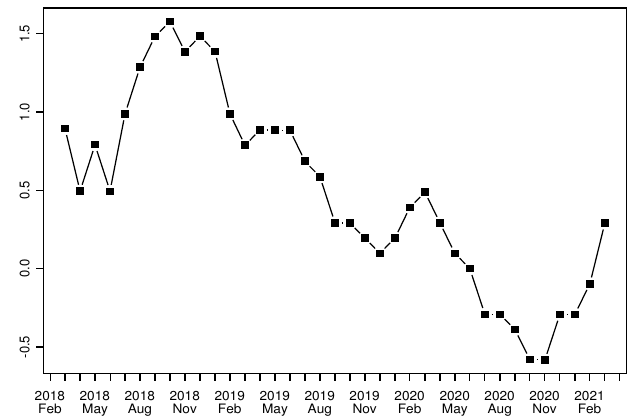
Figure 1. Consumer price monthly inflation